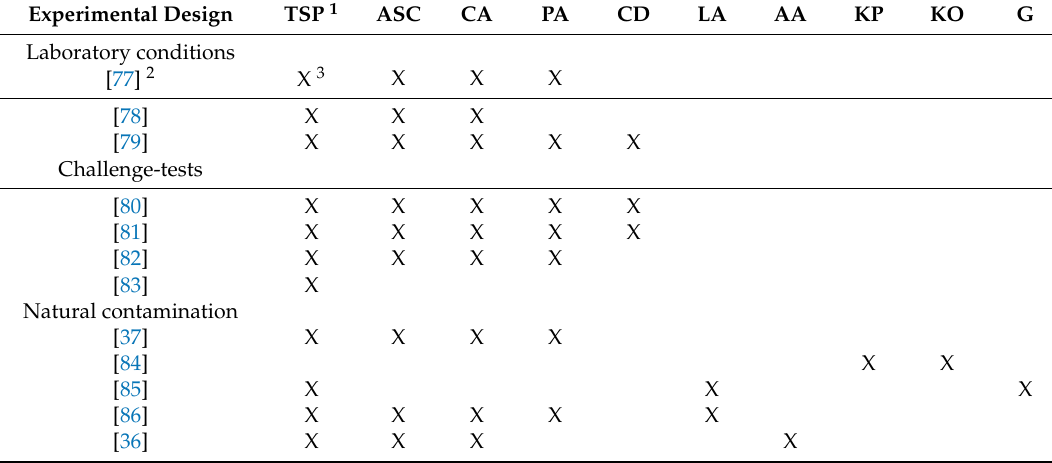
Table 4. Examples of sanitizing treatments tested and experimental